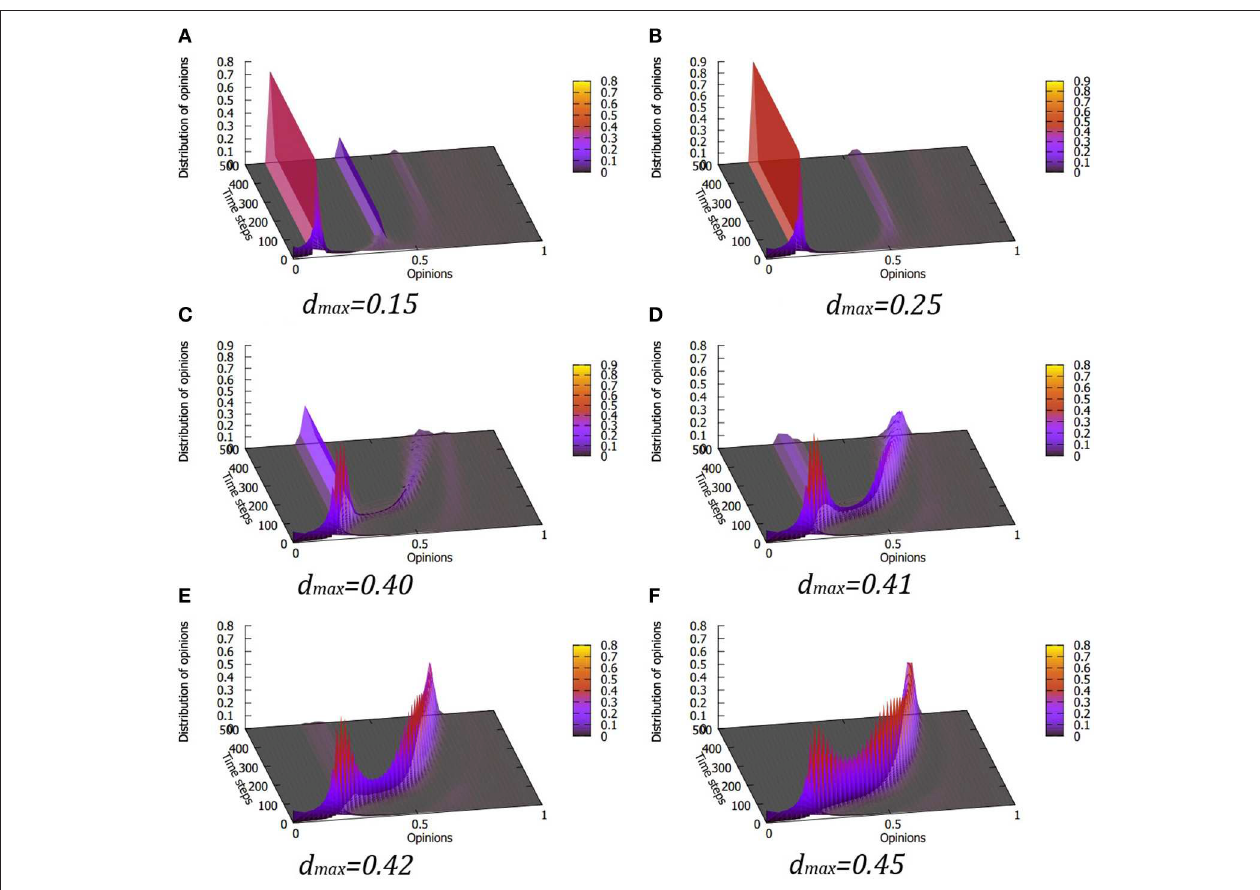
consensus. The evolution is, however, much slower than in the case of the uniform initial opinion distribution. Still, even a small number of zealots can convince the whole society eventually to their views. Panels (A–F) correspond to d max values of 0.15, 0.25, 0.40, 0.41, 0.42 and 0.45,